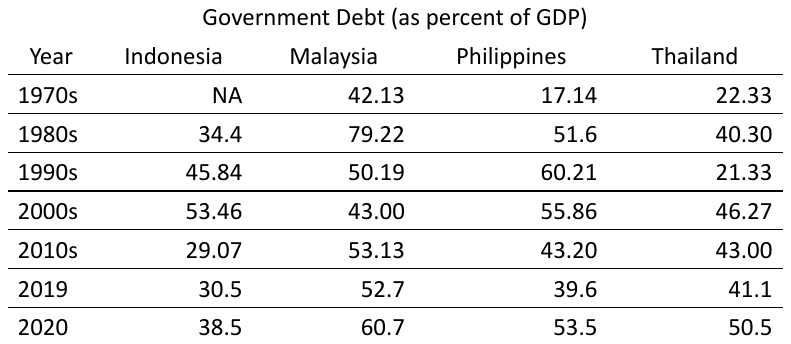
Table 1: Average government debt level in five decades in